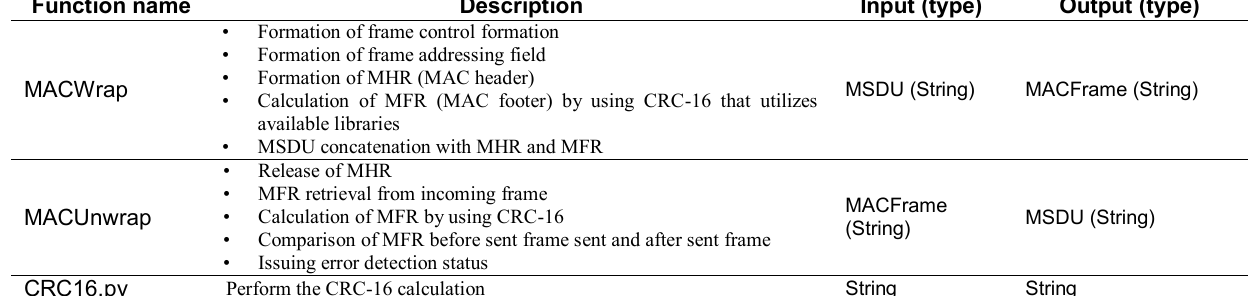
Table 1. The functions and descriptions of the designed MAC layer in Python script